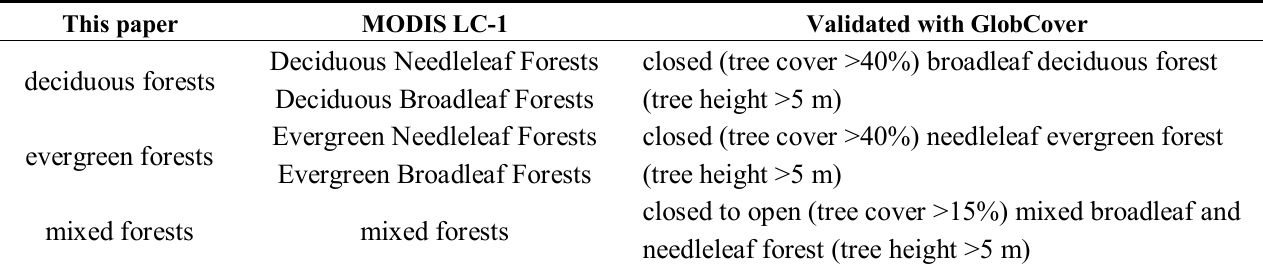
Table 2. The definitions of different forest